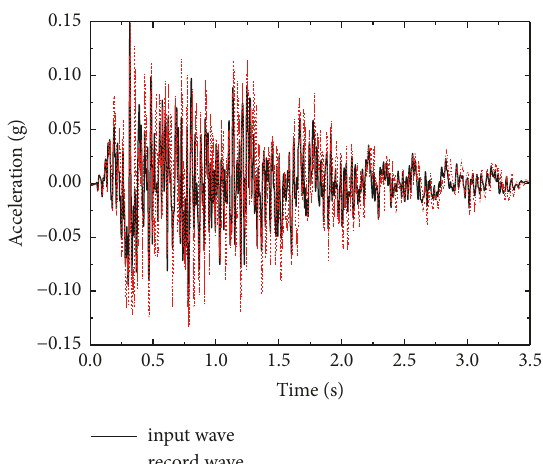
Figure 10: Acceleration time history waves.